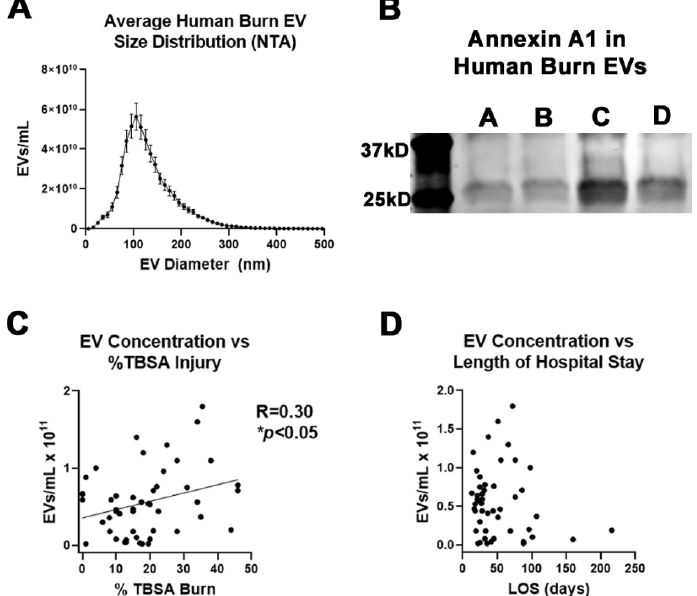
Figure 6. Assessment of human plasma EVs from human burn patients. Plasma EVs were